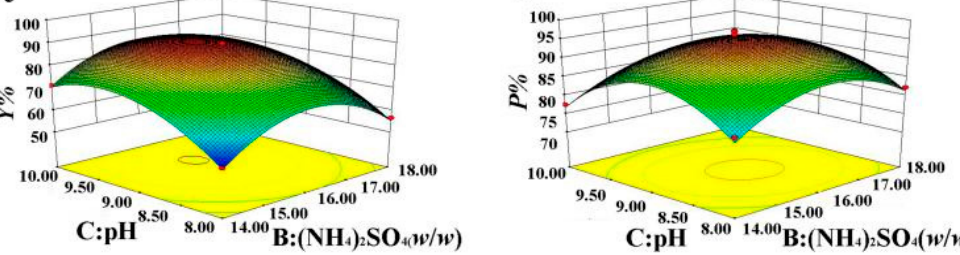
Figure 2. Response surface plots for Y ( a , c ) and P ( b , d ) of OVA.